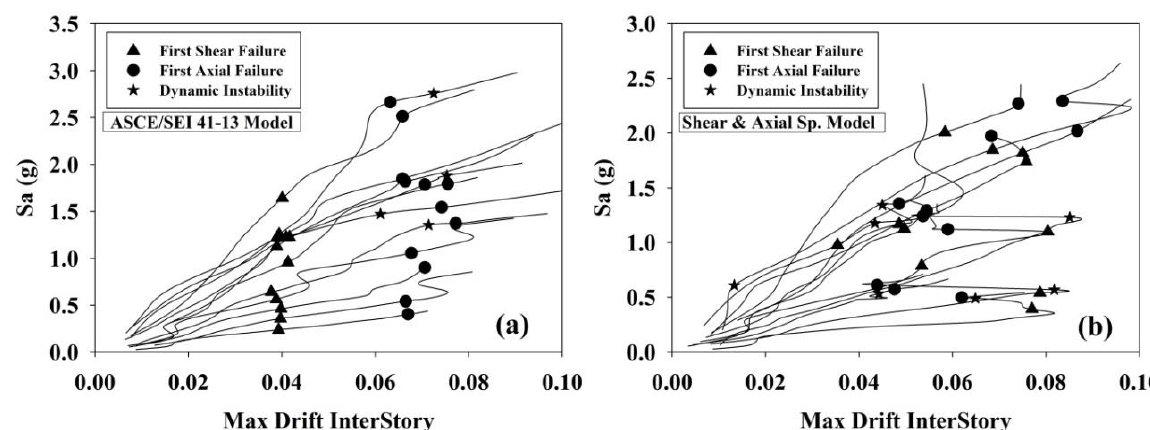
Fig.12. Sa (g) Vs. Maximum Inter-story drift ratio for 5-Story model with P/Ag.f’c =0.12, S=200mm. a) ASCE/SEI 41-13 modeling approach, b) shear and axial springs modeling